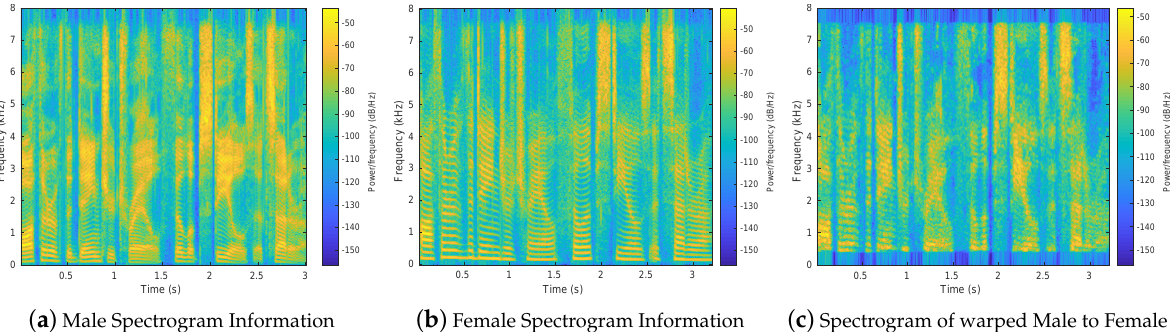
Figure 4. Spectrogram for male, female and warped male to